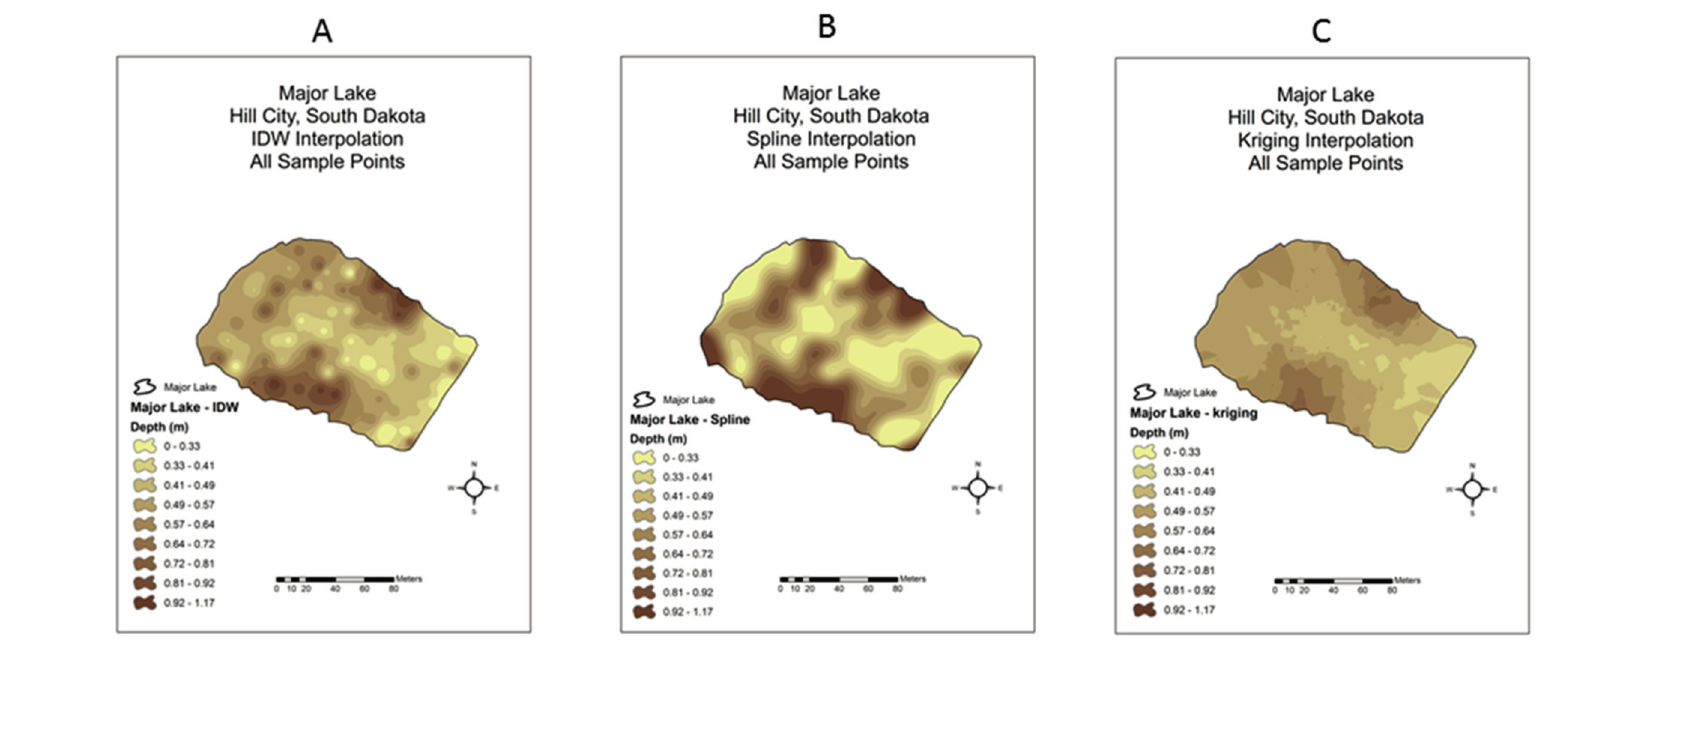
Figure 5. Sediment maps of Major Lake within the Black Hills of South Dakota using IDW interpolation to depict extent and distribution of sediment within the lake. Inverse Distance Weighted is identified with the subset letter ( A ), Spline is identified with the subset letter ( B ) and kriging is identified with the subset letter ( C